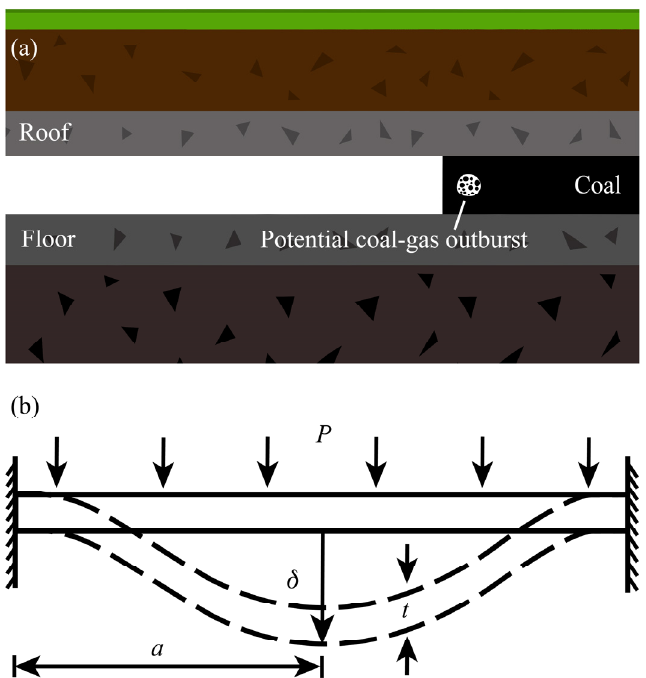
Figure 1. ( a ) Schematic of the roadway with the potential coal-gas outburst in the coal seam. ( b ) Schematic of the deflection of roof and coal wall, where P is the pressure caused by rock gravity or gas congregation, t is the thickness, δ is the deflection in the middle of the plate, and a is the half-length of the plate.